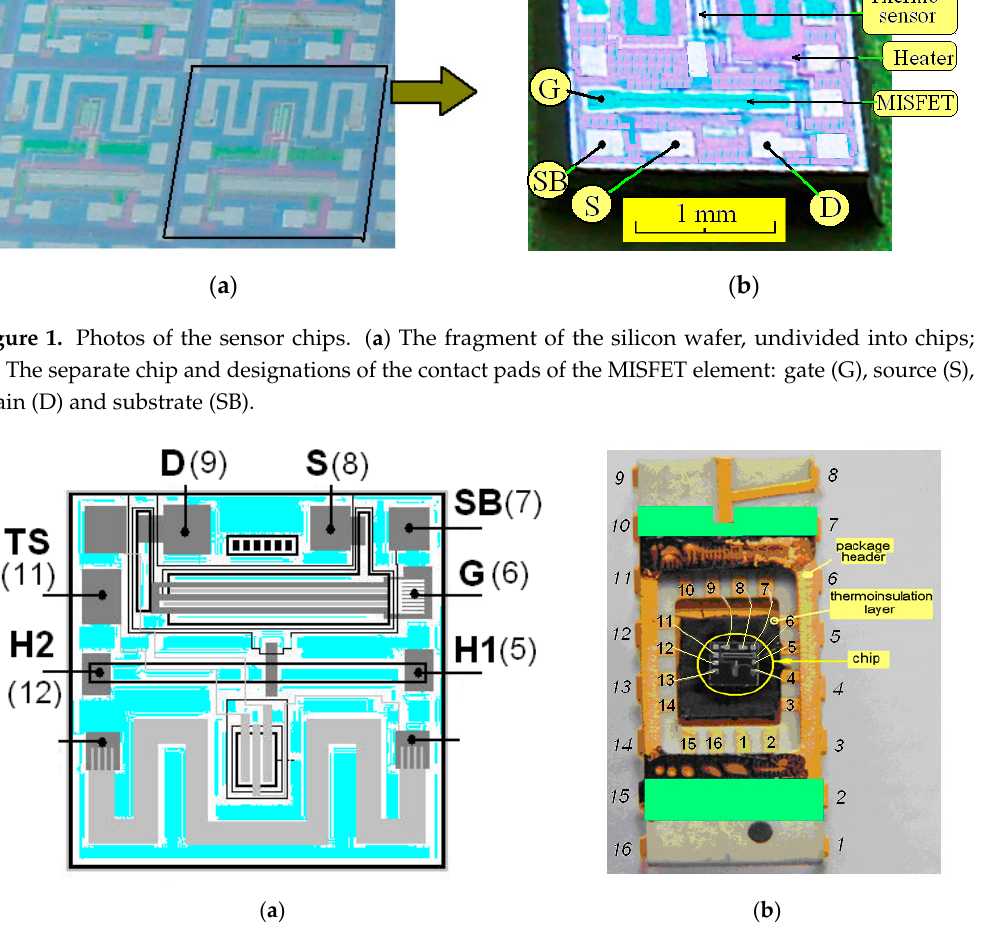
Figure 2. The sensor chip. ( a ) Layout and designations of the contact pads and the pin numbers of elements of a sensor integrated cell: gate (G), source (S), drain (D) and substrate (SB) of Pd–Ta 2 O 5 –SiO 2 –Si FET, the source of Al–SiO 2 –Si FET (TS) and heater-resistor (H1–H2); ( b ) The chip in the sensor housing without cover (numbers are the numbers ouputs’ terminals of the chip).